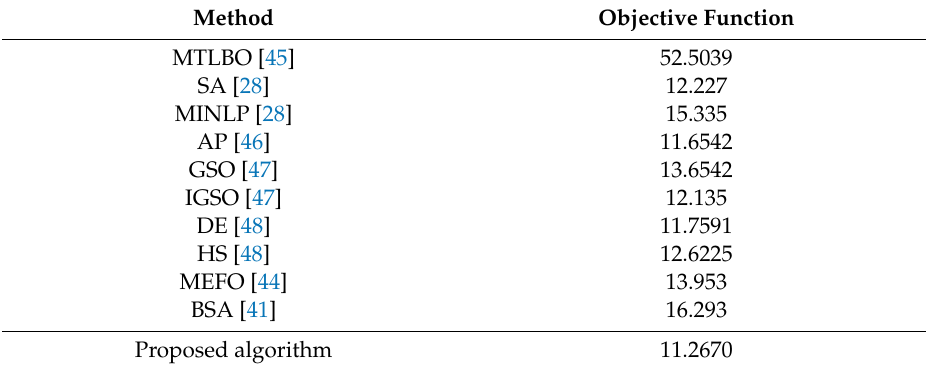
Table 14. Comparison of the WOA result with the methods used in the literature for the IEEE 15-bus system.